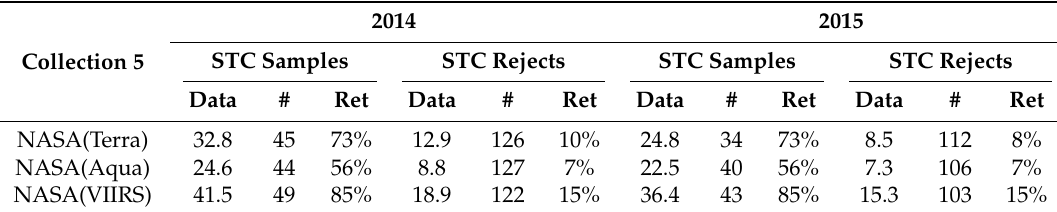
Table 4. Shown are the proportion of river grids sampled as clear-sky by NASA processing when STC accepts (few clouds) or rejects (cloudy) a scene for 2014 and 2015. Data: see Equation (2); #: number of